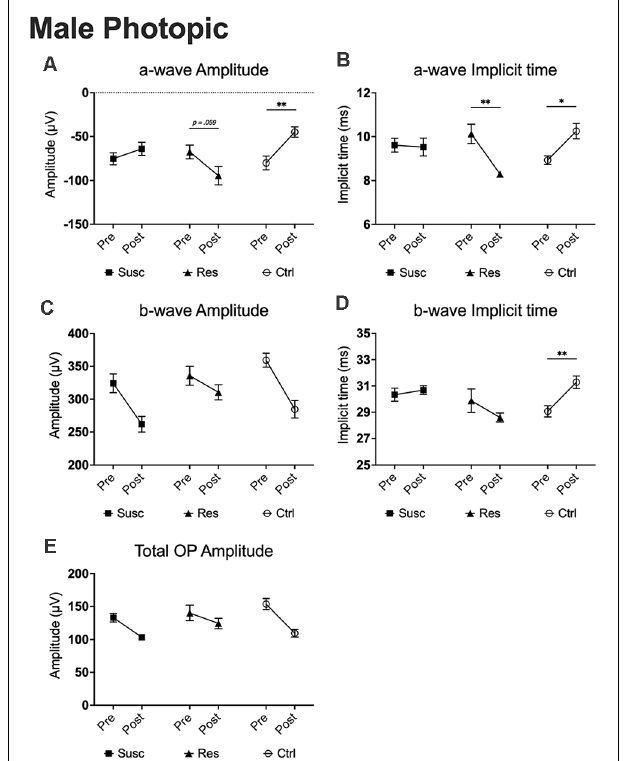
FIGURE 7 | The evolution of each ERG component under the photopic condition at baseline and after CSDS in male mice representing the susceptible, resilient, and control a-wave amplitude (A) , a-wave implicit time (B) , b-wave amplitude (C) , b-wave implicit time (D) , and total OP amplitude (E) . Significance was determined using linear mixed model analysis with LSD multiple comparisons test. Symbols and bars represent the group average ± SEM; ∗ p < 0.05, ∗∗ p < 0.01; n -values are given in the “Materials and Methods”